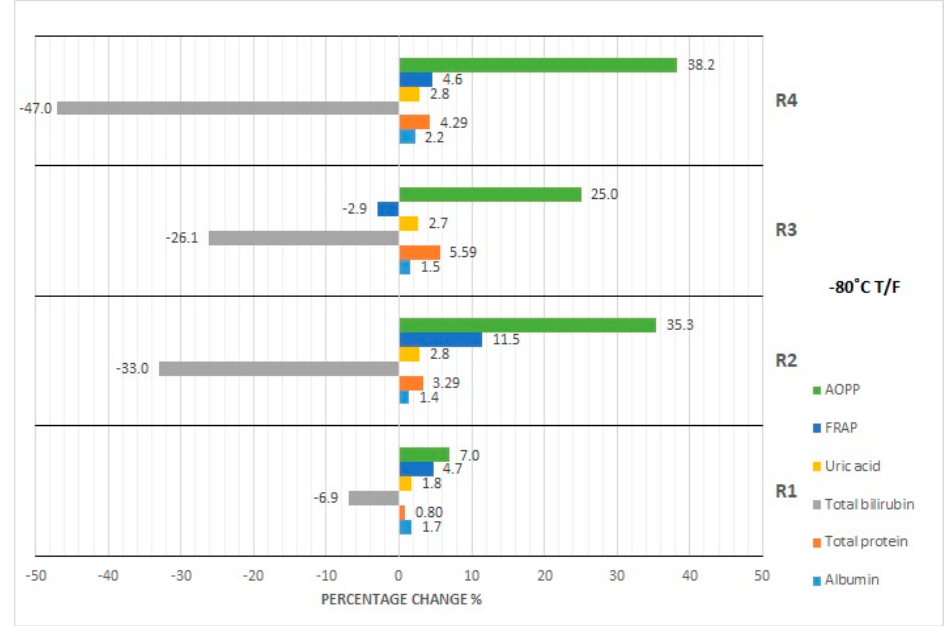
Figure 5. Percentage changes in concentration of selected parameters after cyclic thawing of serum samples (R1-R4) at − 80 °C. AOPP—advanced oxidation protein products, FRAP—ferric reducing ability of plasma, UA—uric acid, Bil—bilirubin, TP—total protein, Alb—albumin.